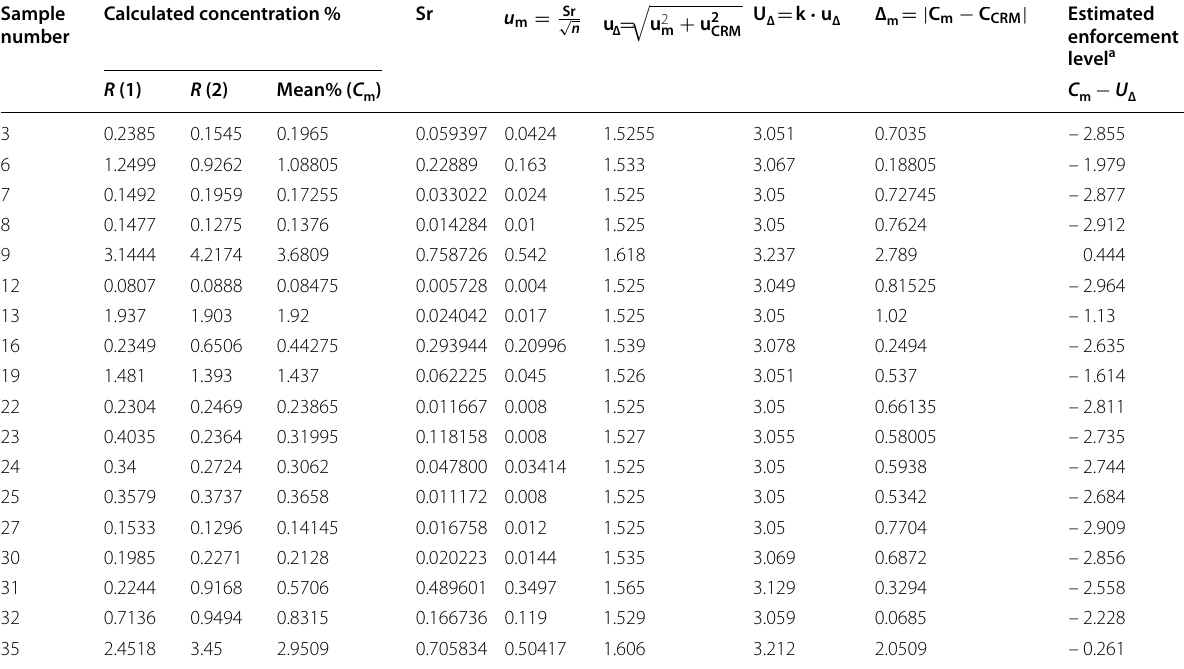
Table 5 Measurement Uncertainty using the value of within‑laboratory measurement